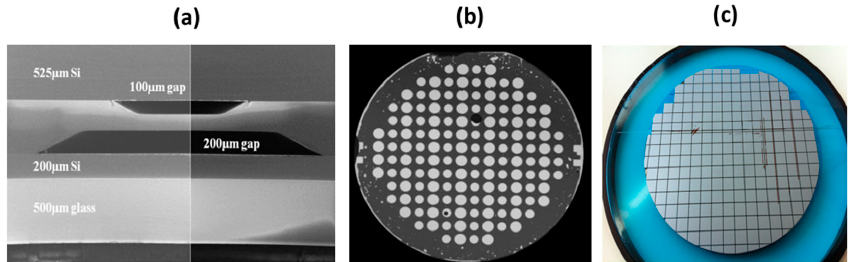
Figure 22. Multi-wafer test anodic bonding for 3D microscanner: ( a ) cross-section of anodically bonded Si-Glass-Si-Glass stack of structurized wafers; ( b ) inspection of bonding quality using scanning acoustic microscopy; and, ( c ) successful dicing experiment.